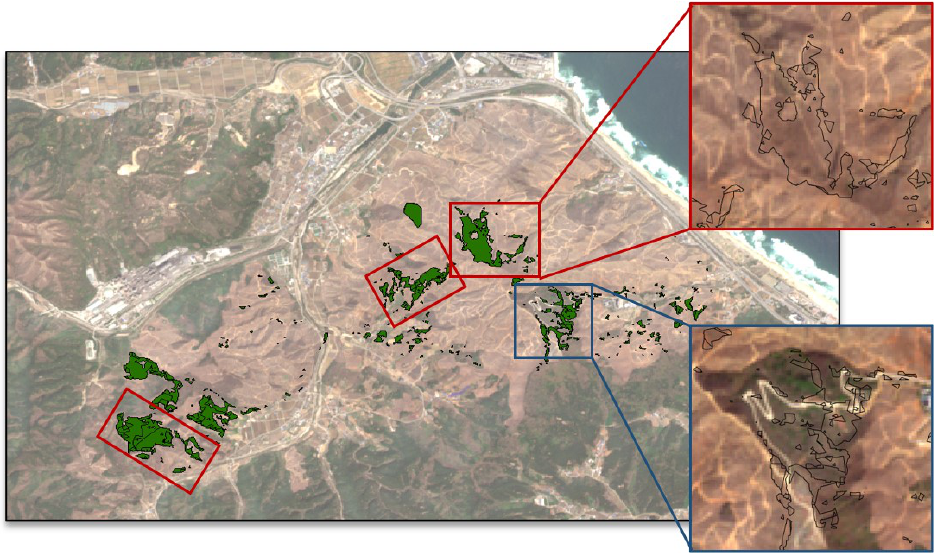
Figure 9. Final vegetation regenerative regions based on the proposed method. The background of Figure 9 is the true color image newly taken on 14 April